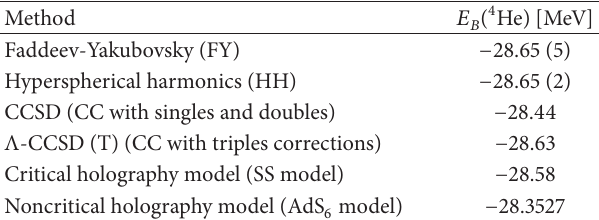
Table 10: Comparison of the 4 He binding energy obtained from our model with the results of some other theoretical models based on chiral low-momentum interactions [62,